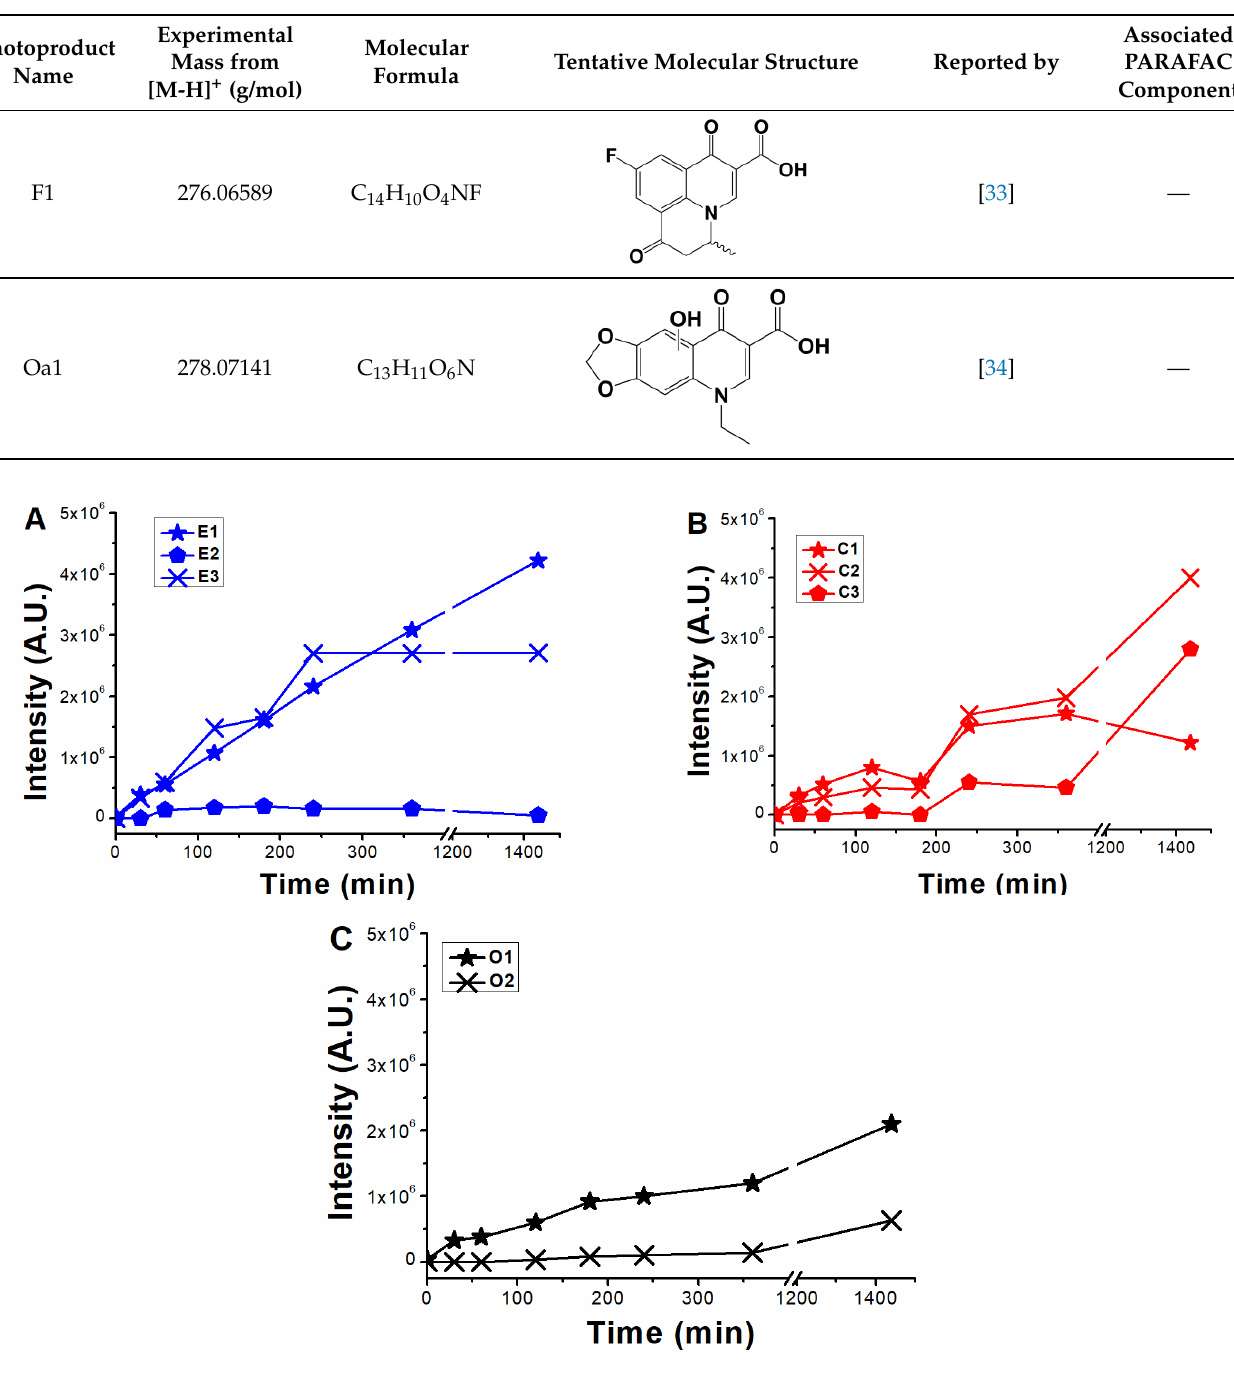
Figure 5. Photoproduct formation during photolysis of 12.5 µM standard solutions of: ( A ) enrofloxacin (formation kinetics of E1-E3), ( B ) ciprofloxacin (formation kinetics of C1-C3), and ( C ) ofloxacin (formation kinetics of O1 and O2). The signal intensity for the photoproducts found from oxolinic acid and flumequine photolysis were negligible in both cases, and results are not shown. Table 1. EEM-PARAFAC correlation with UHPLC-HRMS results. The transformation products were named with a first letter associated to the compound which were generated, and a number linked to the oxidation degree: E1 – E3, from Enrofloxacin; C1 – C3, from Ciprofloxacin; O1 and O2, from Ofloxacin; F1, from Flumequine; and Oa1, from Oxolinic acid.